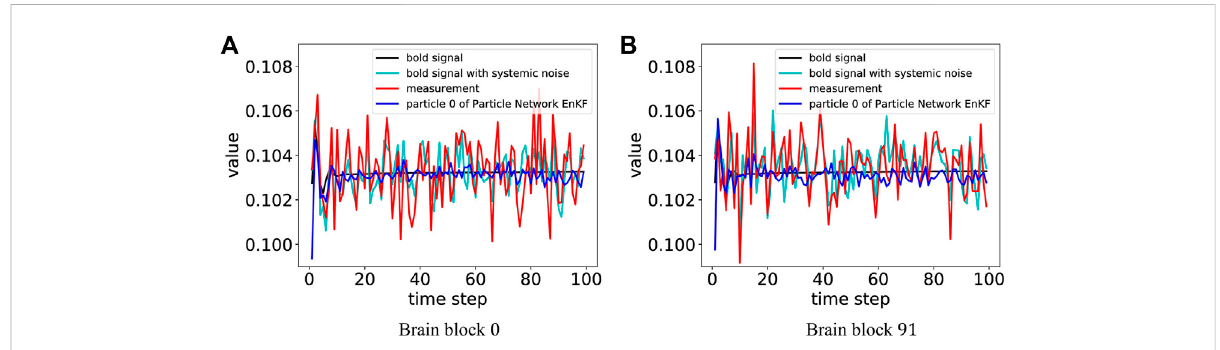
FIGURE 8 The results of the fi ltering bold signal for blocks 0 and 91. For the Particle Network EnKF, we only depict the performance of particle 0 as an example. (A) shows the result for the brain block 0 and (B) shows the result for the brain block 91.